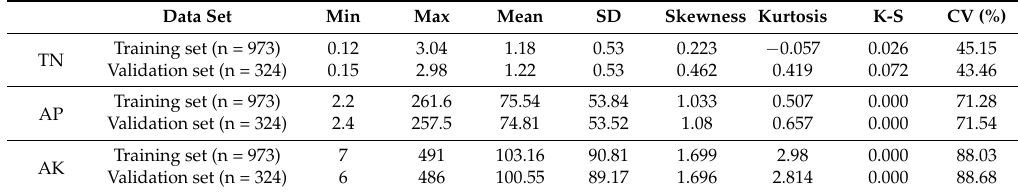
Table 1. Descriptive statistics of soil nutrients (mg kg − 1 ) in the study